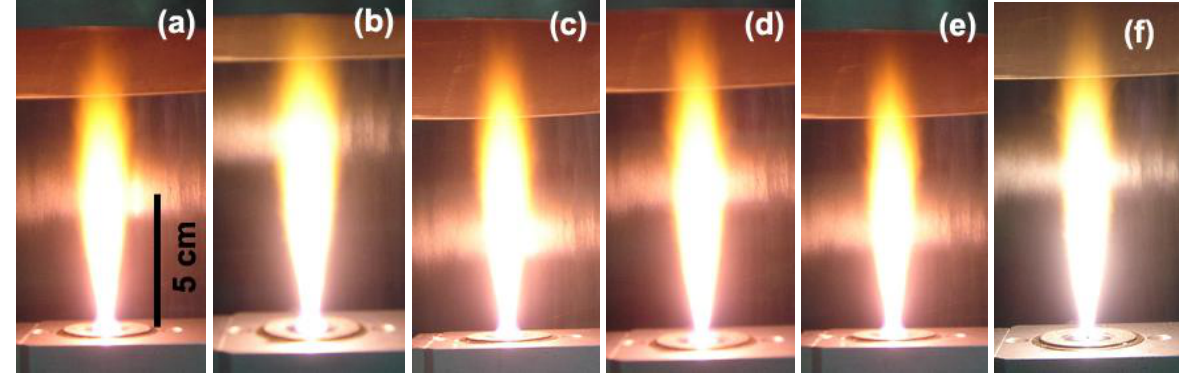
, (b–f) 0.2–3 wt% Ru/SnO nanoparticles 2 2 (5 l/min) at 1.5 bar 2